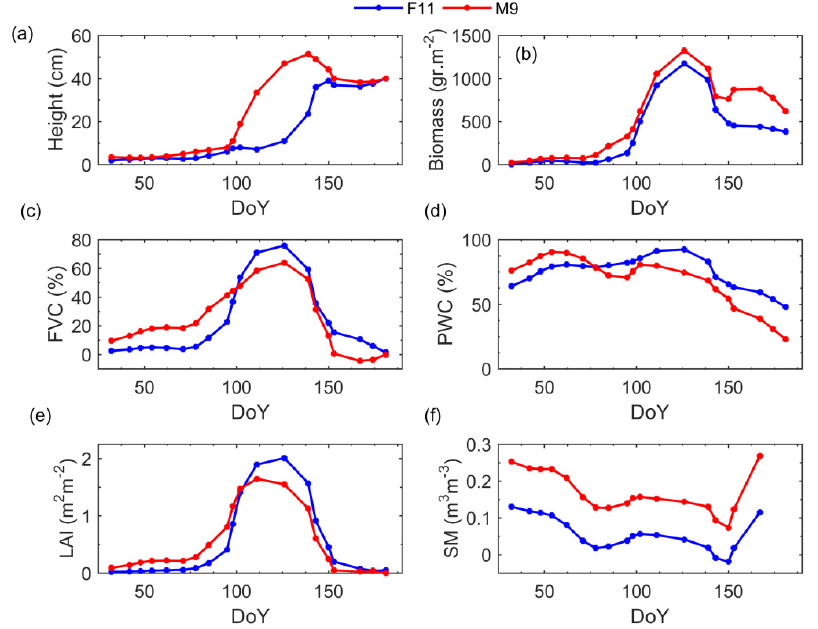
Figure 9. Temporal evolution of: ( a ) height; ( b ) biomass; ( c ) fraction of vegetation cover; ( d ) per- centage of water content; ( e ) leaf area index; and ( f ) soil moisture interpolated data of F11 and M9 plots.